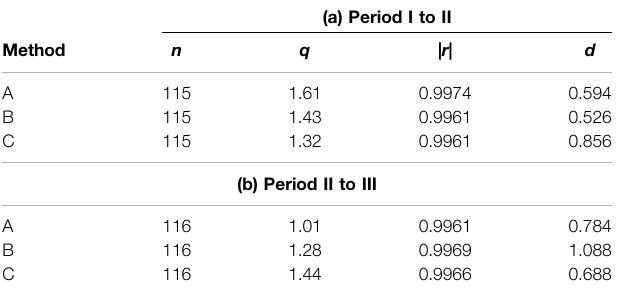
TABLE5| Comparisonofoptimal fi ttingparametersintherankdependenceofthe intersectingangle ofthemonthlytemperaturesontheWorldstations. (a)From Period I (from 1931 to 1960) to Period II (from 1951 to 1980); (b) From Period II (from 1951 to 1980) to Period III (from 1981 to 2010).